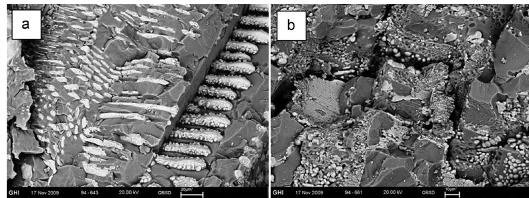
Figure 3. Fractographies by SEM of eutectic electrofused aggregates: a) mullite-zirconia 16 b)